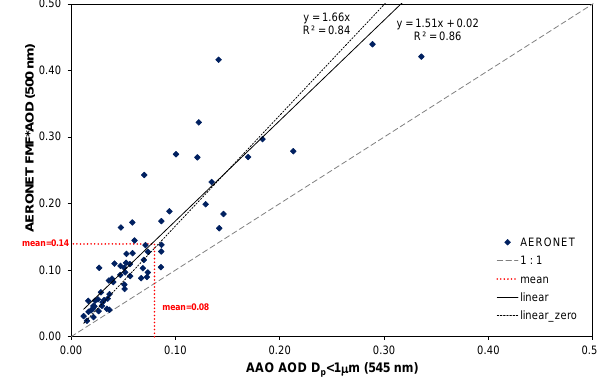
Fig. 11. Comparison of AAO aircraft calculated submicrometer AOD (at 545nm) with AERONET Fine AOD (at